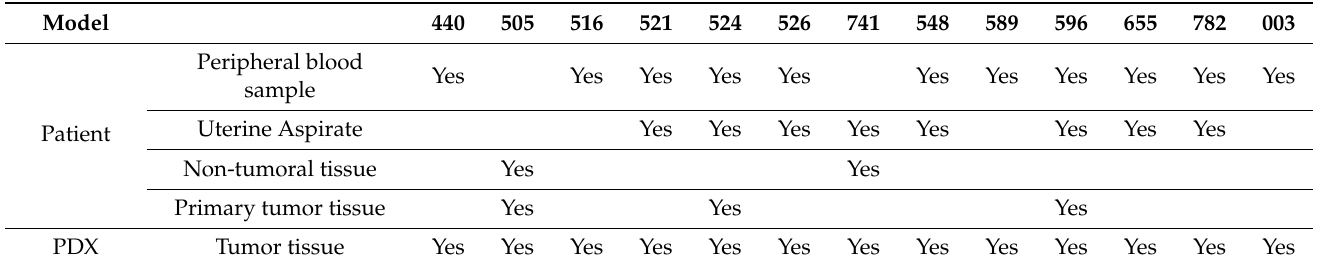
Table 2. Type of samples collected and processed from patient and PDX for DNA extraction and WES